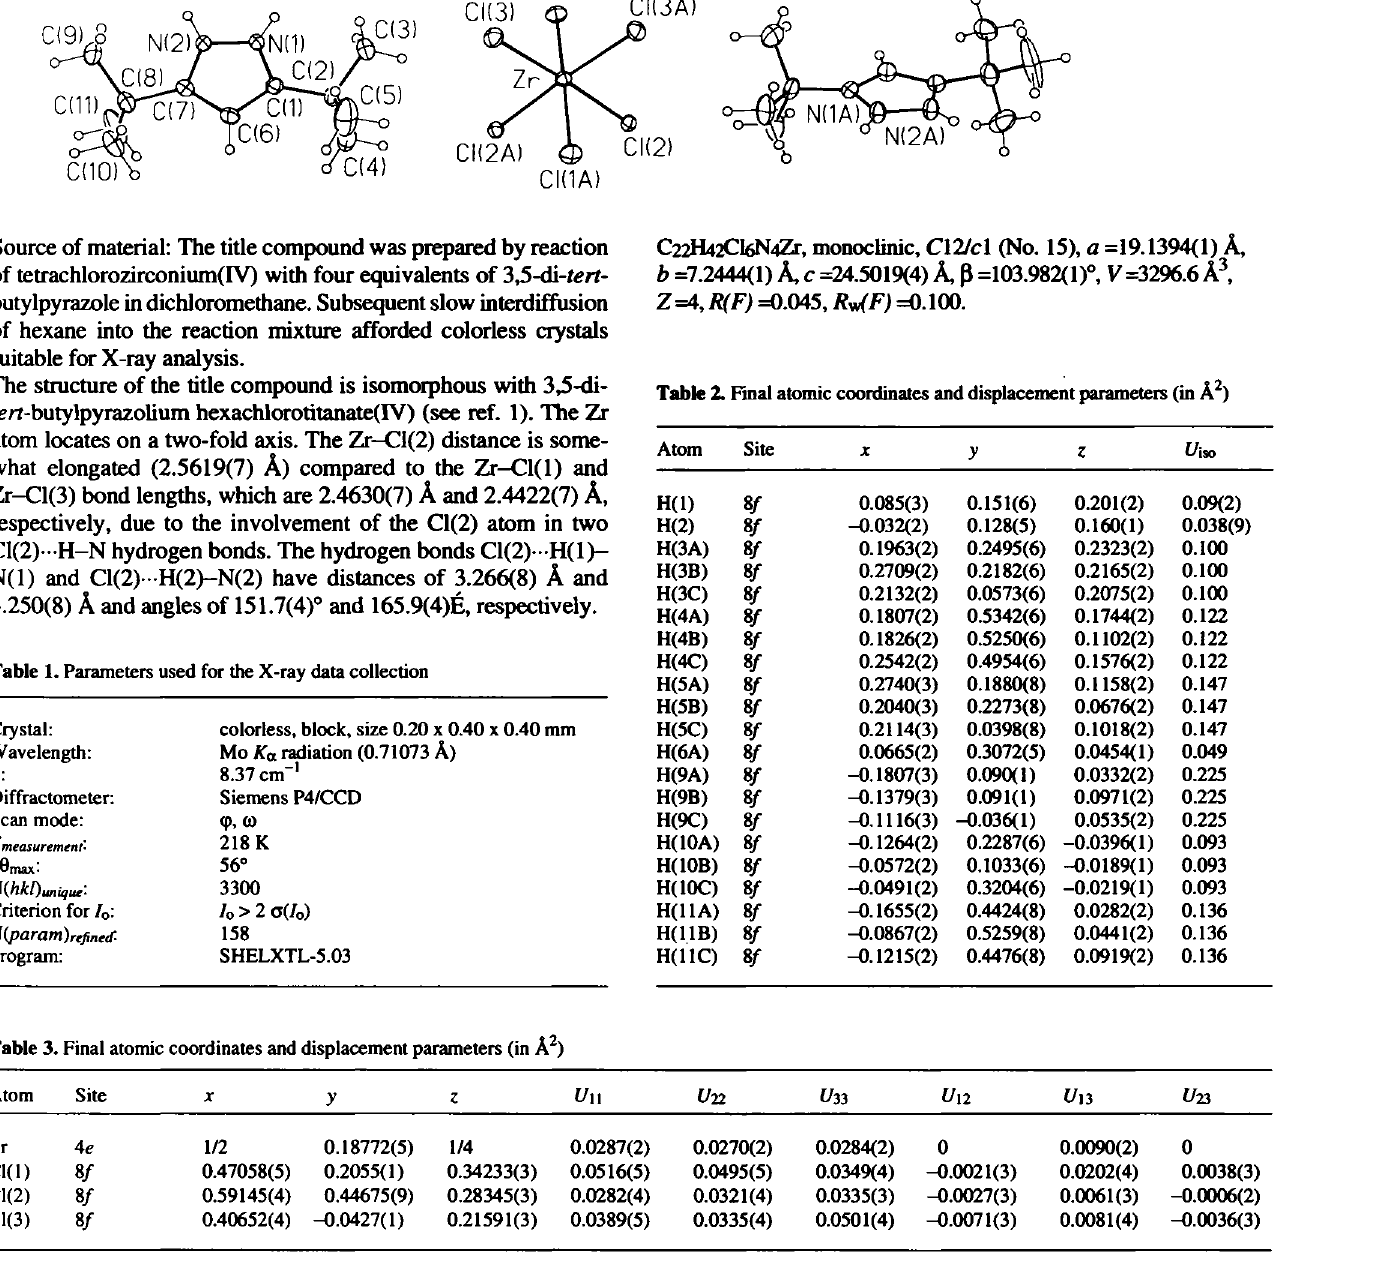
Table 3. Final atomic coordinates and displacement parameters (in